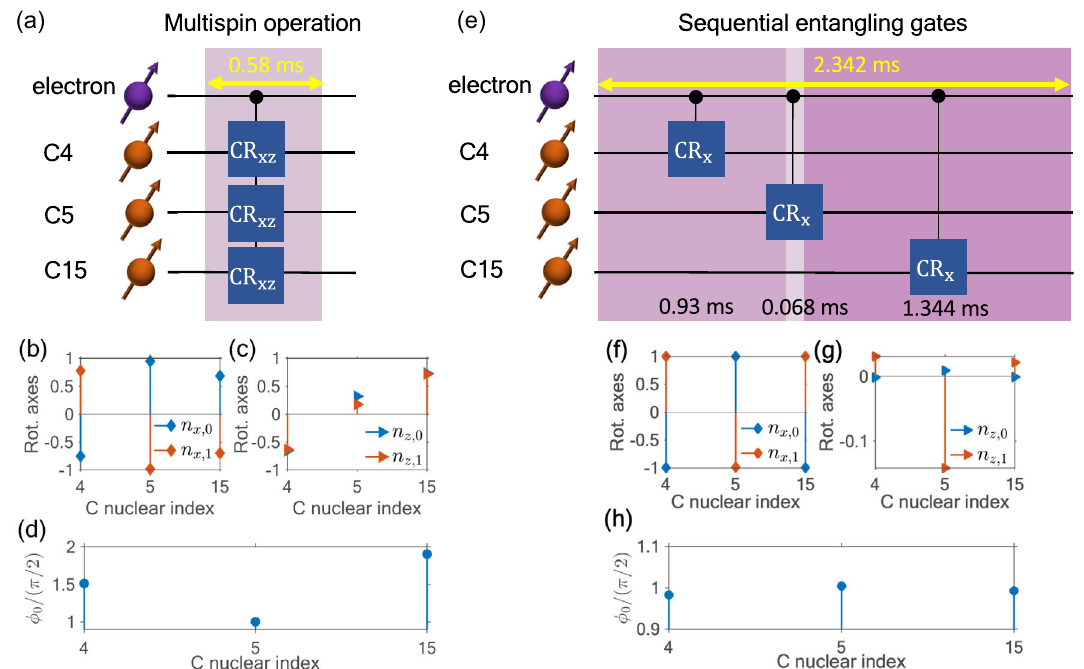
FIG. 9. Comparison of synchronous multispin gate scheme with the sequential entanglement protocol. Circuit diagram for (a) multispin entangling gate operation and (e) sequential entangling protocol. The x -axis components (b),(f) and the z -axis components (c),(g) of the 13 C nuclear spin rotations are shown. The subscripts “ 0 ” and “ 1 ” on the axis components refer to the nuclear rotations R n . (d),(h) The rotation angle of each nucleus. (b) – (d) correspond to the multispin operation, while (f) – (h) correspond to the j sequential entangling protocol. The exact parameters of the rotation axes and rotation angles are given in Table XI in Appendix K 4. Lighter shading in (a) and (e) indicates shorter gate